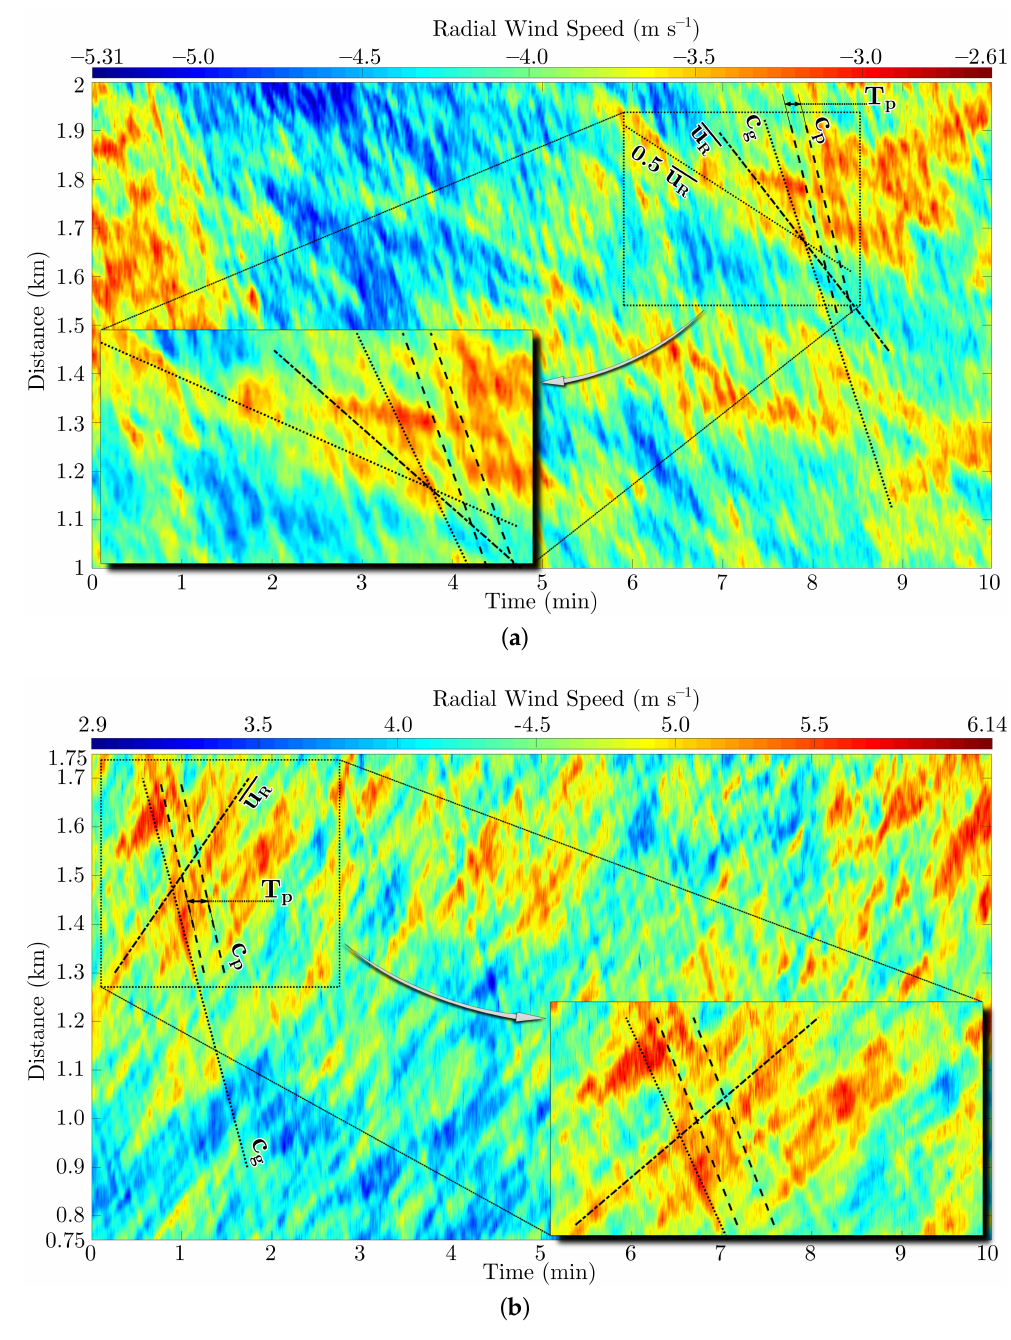
Figure 4. 10-min records of the Radial Wind Speed (RWS) from ( a ) Case 01, and ( b ) Case 02a. Mean RWS in dash-dotted lines. Peak wave phase and group velocities ( c p and c g ) slopes as dashed and dotted lines, respectively, dashed lines being distant by T p (Table 3). An indicative value of 0.5 RWS is provided for comparison in ( a